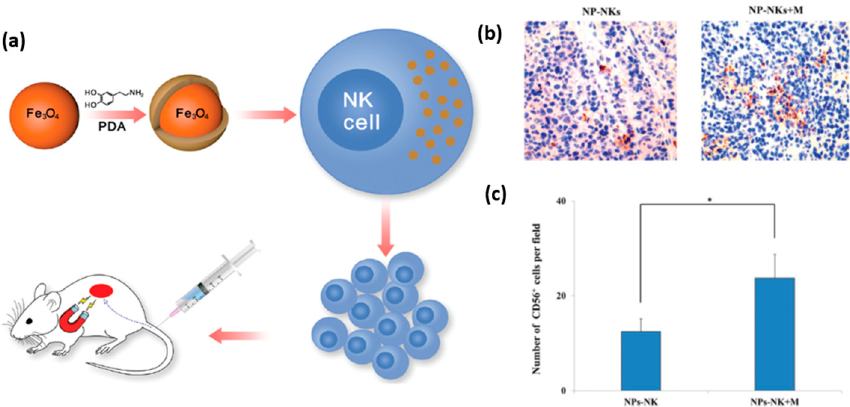
Figure 9. Functionalized nanoparticles for magnetically guided delivery of NK cells. ( a ) Scheme of the entire experimental setup. ( b , c ) Distribution and quantitative analysis of the particle labeled NK cells administered by intravenous injection and accumulated at the tumor site after 12 h, with and without magnetic field (Mag: 200×; * p < 0.05). Reproduced from Reference [74].